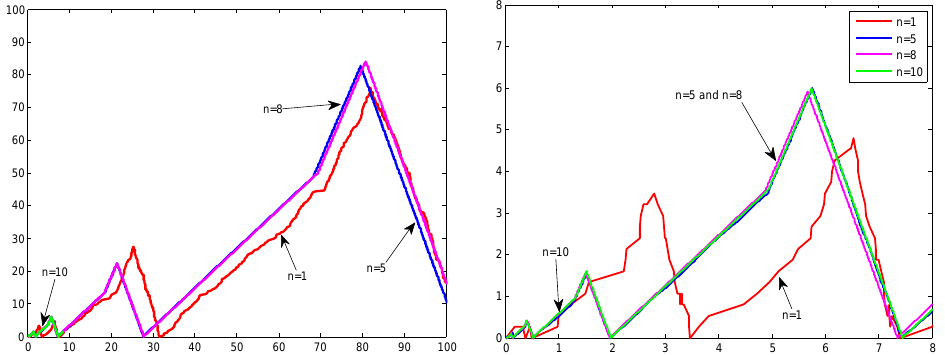
Figure 3: The scaled queue length process of Q 2 for different n (left: t ∈ [0, 100] , right: t ∈ [0, 8] ) with exhaustive service policy.